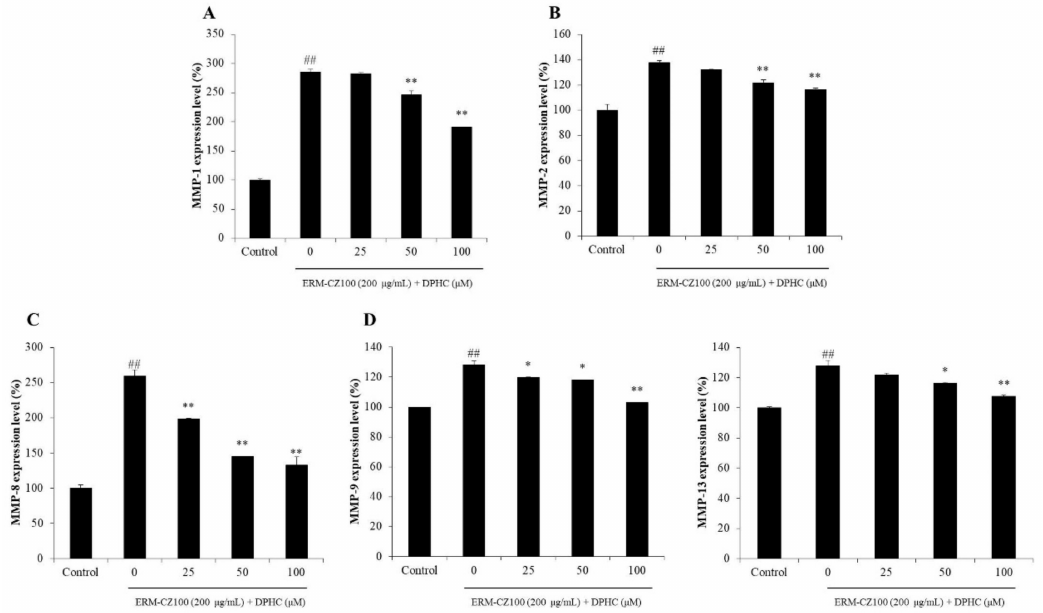
Figure 4. DPHC reduced matrix metalloproteinases (MMPs) expression in ERM-CZ100-stimulated HDF cells. ( A ) MMP-1 expression level in ERM-CZ100-stimulated HDF cells, ( B ) MMP-2 expression level in ERM-CZ100-stimulated HDF cells, ( C ) MMP-8 expression level in ERM-CZ100-stimulated HDF cells, ( D ) MMP-9 expression level in ERM-CZ100-stimulated HDF cells, and ( E ) MMP-13 expression level in ERM-CZ100-stimulated HDF cells. The data were expressed as the mean ± SE ( n = 3). * p < 0.05 and ** p < 0.01 as compared to the ERM-CZ100-treated group, and # p < 0.05 and ## p < 0.01 as compared to the control